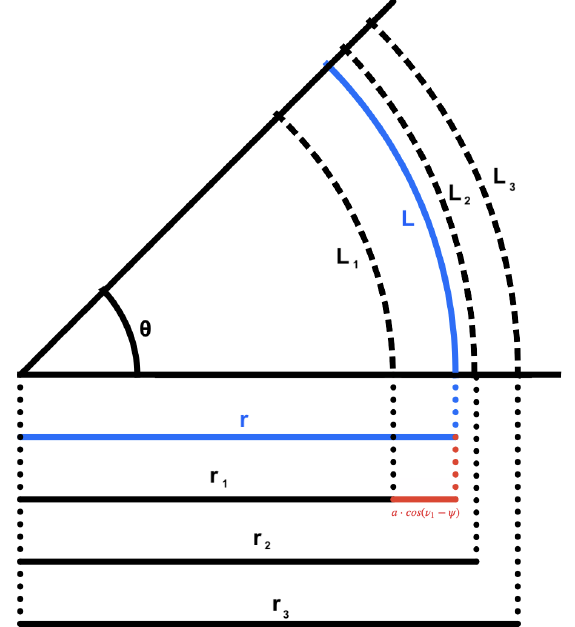
Figure 11. Representation in the perpendicular view of the orientation plane formed by the orienta- tion angle ψ and an inclination angle θ . It can be seen that the projection of the radii of the constant curvature of the soft joint. The central fiber curvature L and its corresponding radius r are represented in blue. The arcs of tendons L i are represented by dashed black lines, and their corresponding radii r i by continuous black lines. The difference between r and r i is represented by a red line whose distance for each tendon is given by equation a · cos ( ν i − ψ ) .